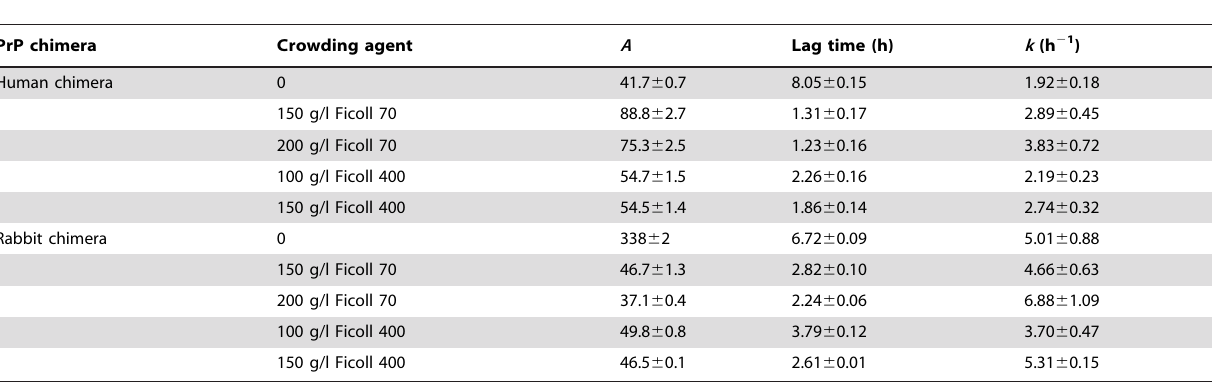
Table 1. Kinetic parameters of amyloid formation of human chimera or rabbit chimera in the absence and presence of Ficoll 70 or Ficoll 400 by ThT binding assays at 37 u